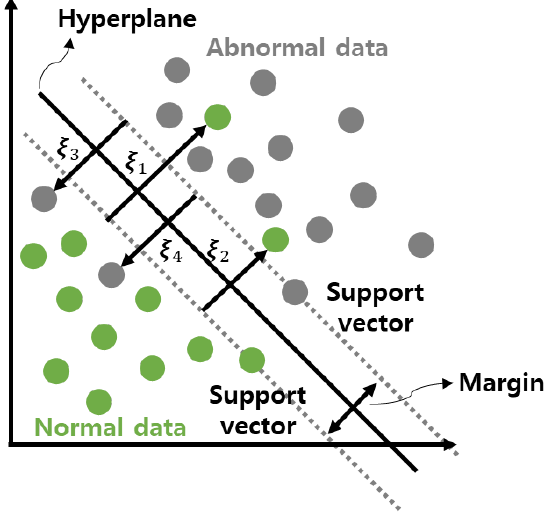
Figure 2. Schematic of the one-class